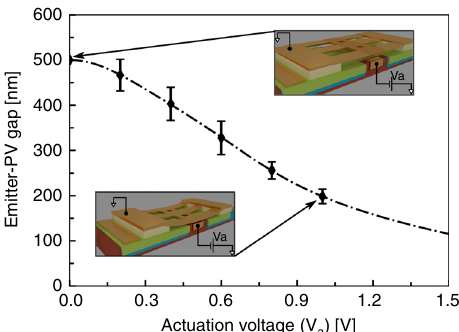
Fig. 3 Nano-electromechanical switch characterization. Displacement of suspended emitter as a function of applied gate-emitter potential difference ( V a ). The broken line represents fi t to a non-linear spring model (see Supplementary Note 7), while the scatter points show the experimental